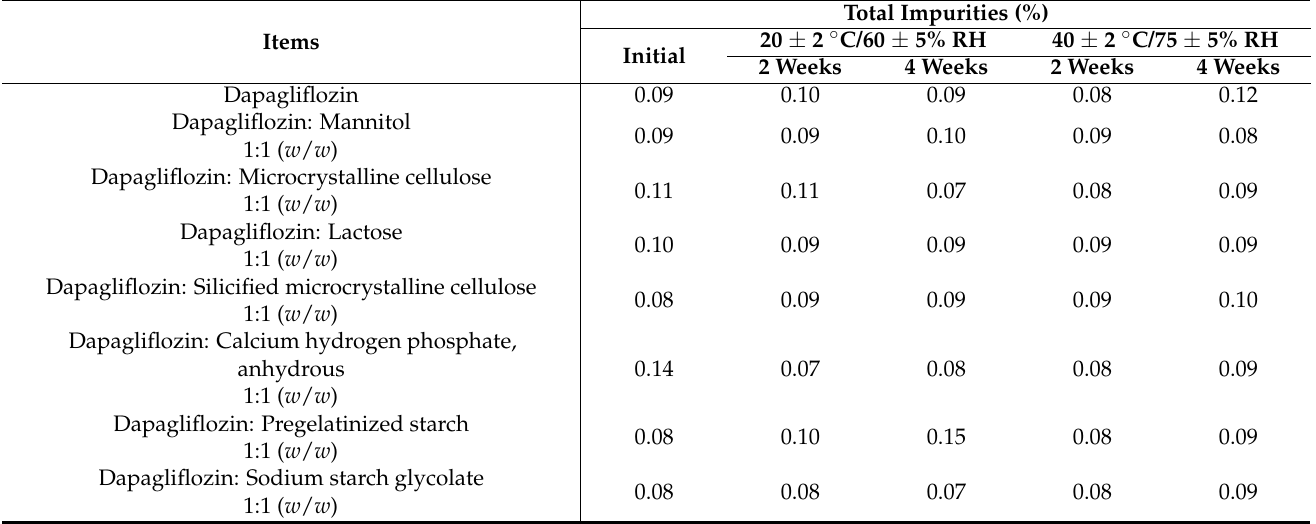
Table 7. Results of compatibility testing between dapagliflozin propanediol hydrate and vari- ous